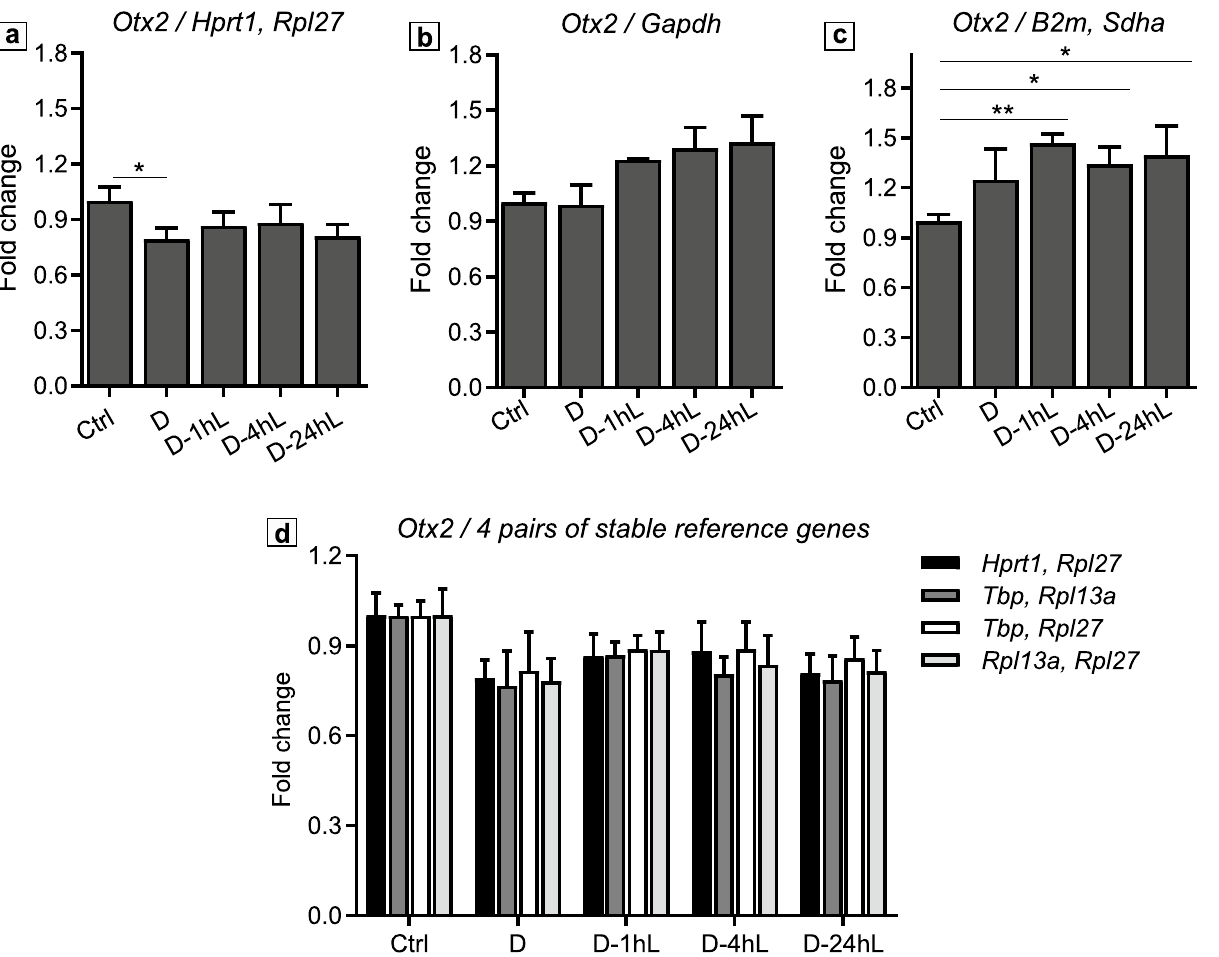
Figure 6. Relative expression of Otx2 normalised to different reference genes. Otx2 relative expression compared to the most stable reference genes in the Light/Dark rearing panel: Hprt1, Rpl27 ( a ); to Gapdh ( b ) and to the least stable genes in the Light/Dark rearing panel: B2m, Sdha ( c ). Otx2 relative expression normalized to Hprt1, Rpl27 versus different combination of the 3 common stable genes Tbp, Rpl13a, Rpl27 ( d ). Data is presented as Mean ± SD, adjusted p-values are indicated as * p ≤